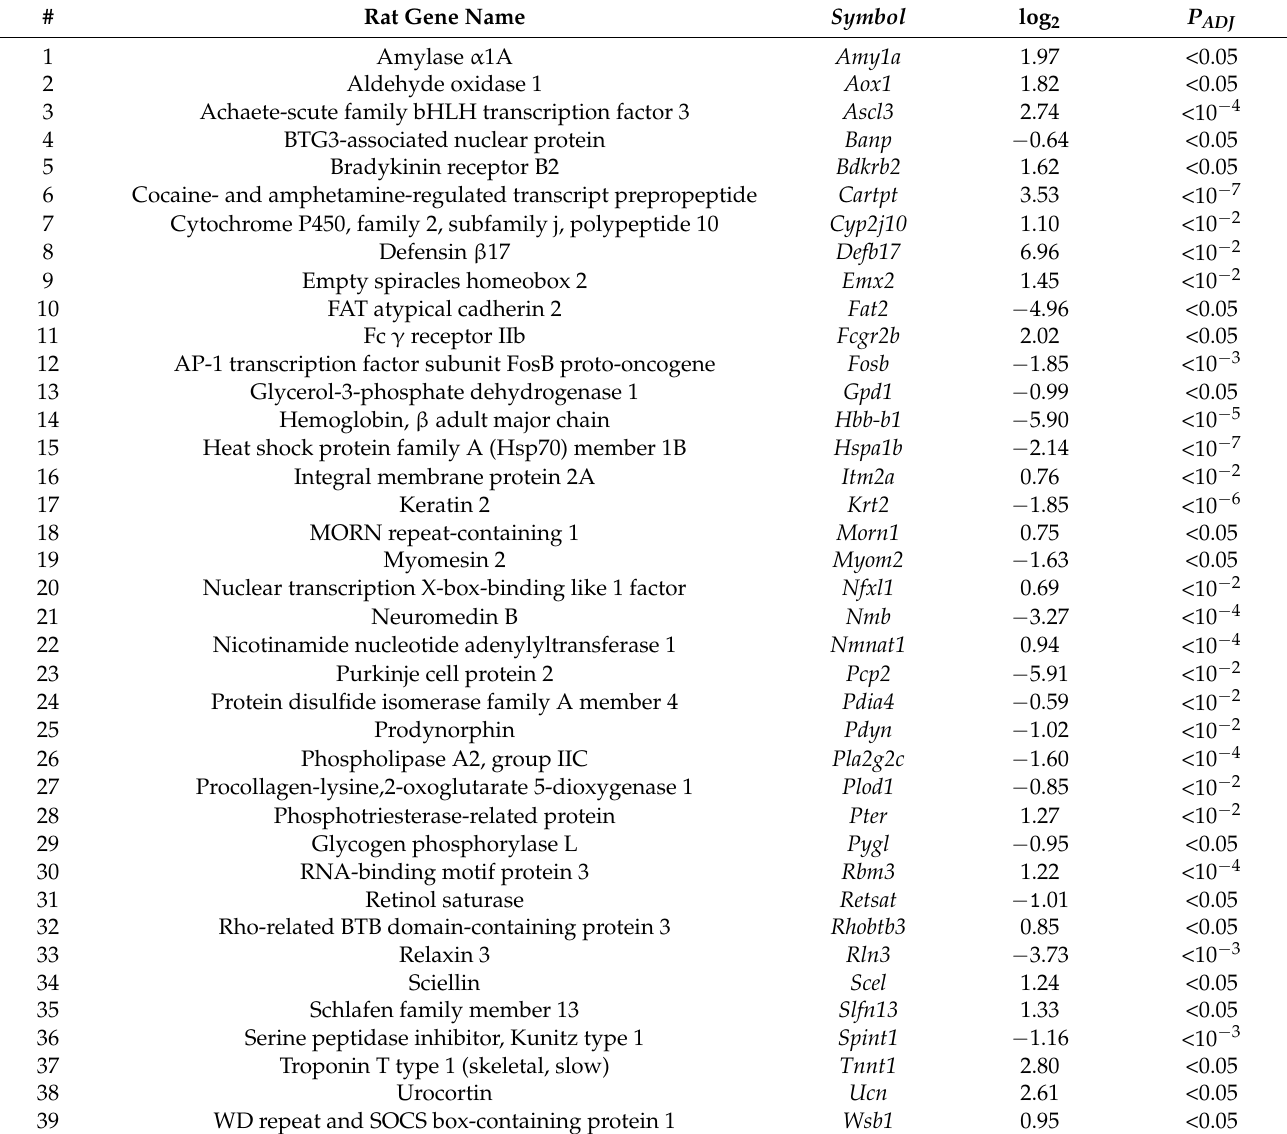
Table 2. Statistically significant DEGs newly identified in the PAG of the tame and aggressive adult male